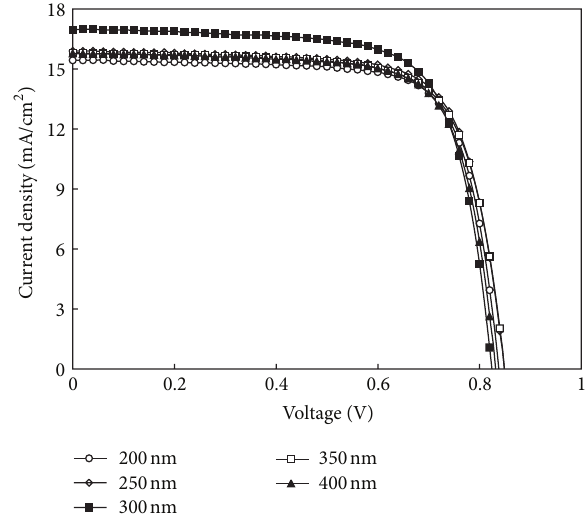
Figure 1: Experimental 𝐼 - 𝑉 characteristics of a-Si:H-like solar cells with different i-layer thickness.